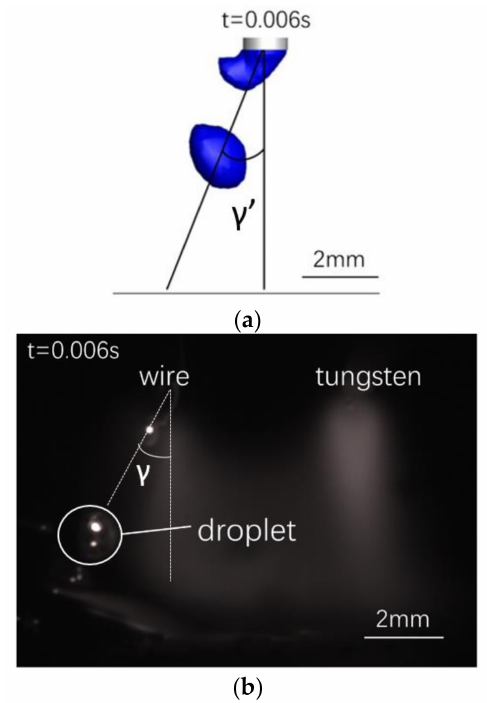
Figure 15. Comparison of ( a ) simulated and ( b ) experimentally observed droplets.